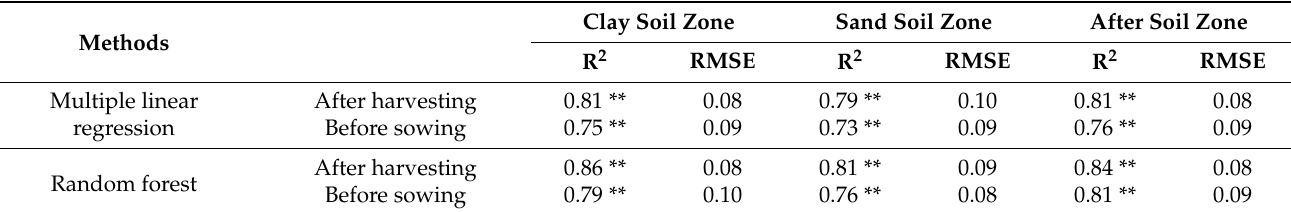
Table 7. Soil texture zoning modelling by different methods.